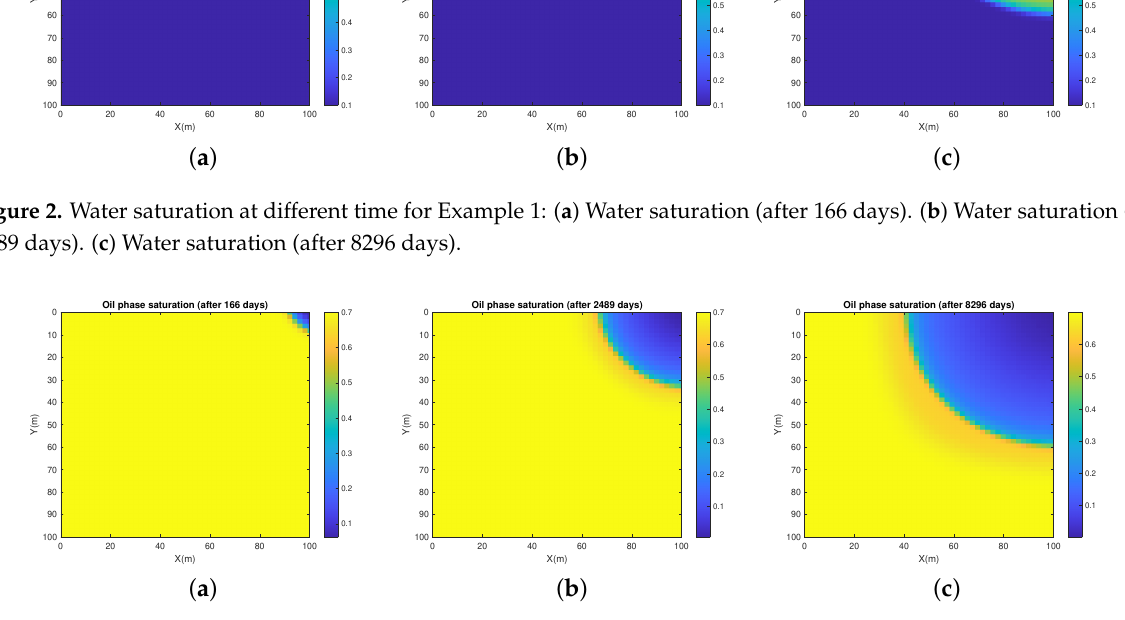
Figure 3. Oil saturation at different time for Example 1: ( a ) Oil saturation (after 166 days). ( b ) Oil saturation (after 2489 days). ( c ) Oil saturation (after 8296 days).